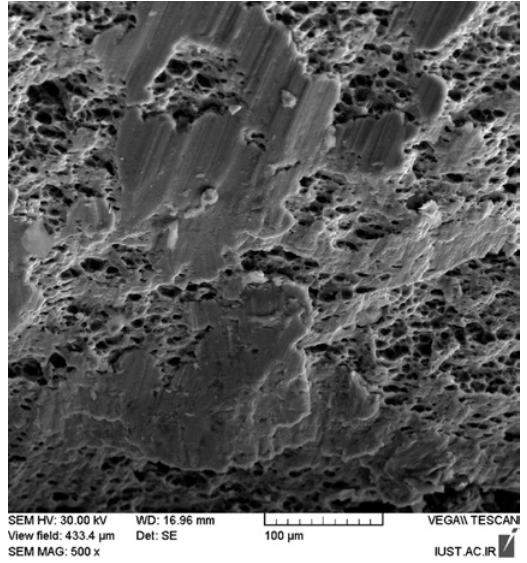
Figure 7: SEM micrograph of the fracture surface of AA8090/6% SiC composite at peak aged under precipitation hardening with p rapid heating.